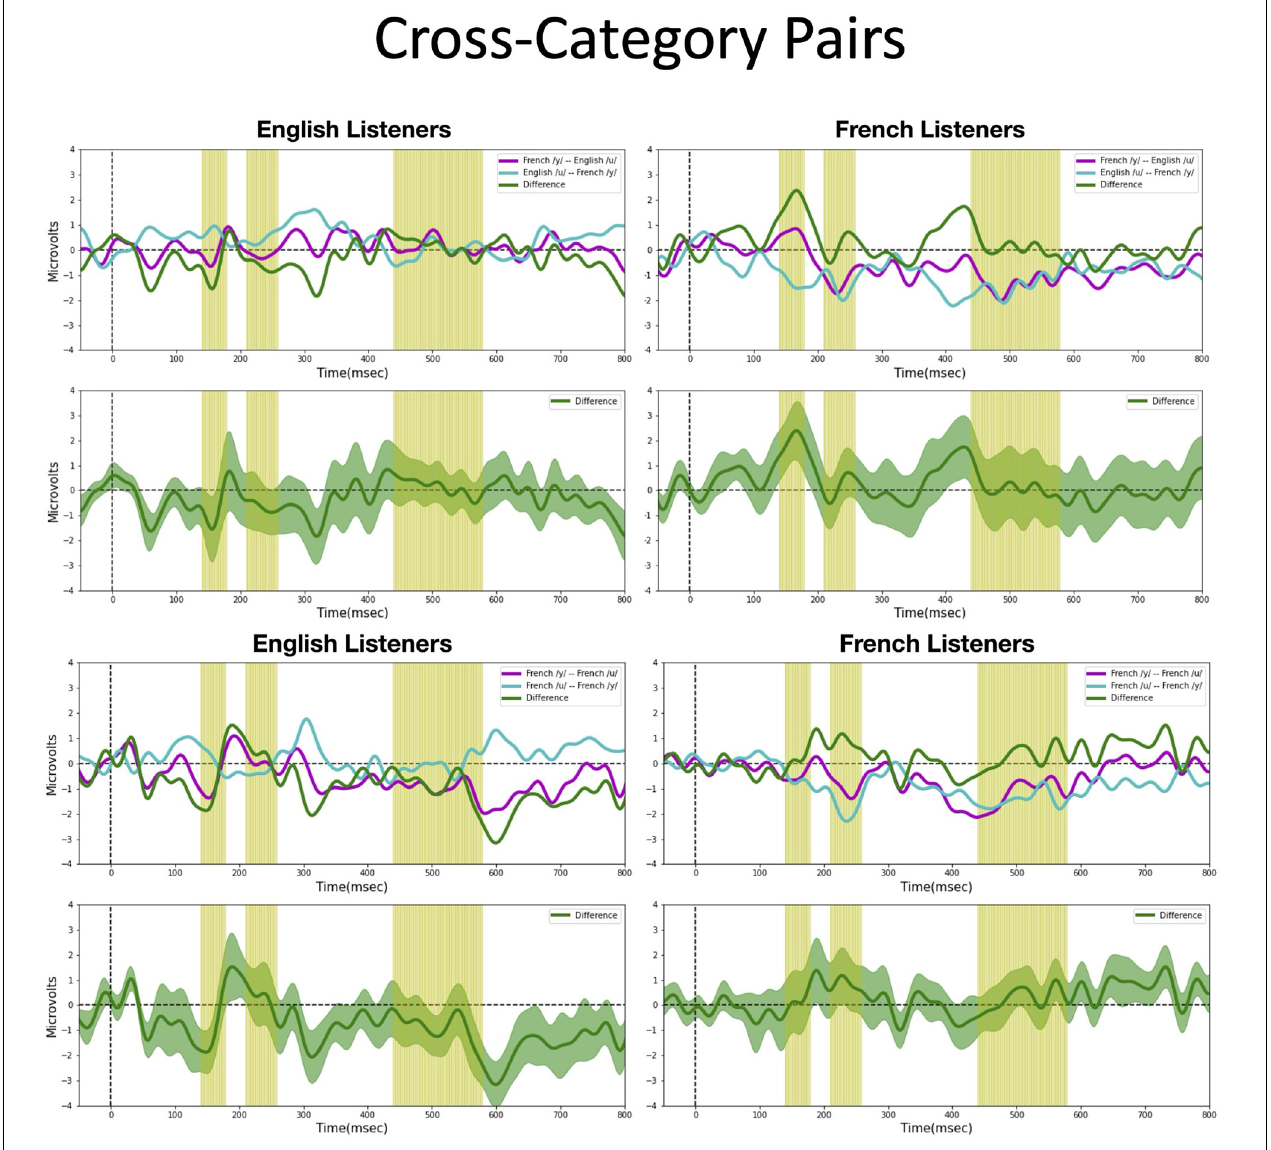
FIGURE 5 | Mismatch negativities (as described in Figure 3C ) for each stimulus type: Cross-category pairs, the mean MMNs for each stimulus presentation order (purple and turquoise lines) and difference waveform (green lines) (in the top half of each panel) and the difference waveform plotted with the standard error for the group (as the dark green shaded region) in the bottom half of each panel. The light green shading indicates the pre-selected time windows used in the hypothesis-based anayses. The MMNs are plotted for each language group wth English Listeners on the left and French Listeners on the right. The vowel pair for each MMN is indicated in the legend at right hand corner of each panel with the standard followed by the deviant (e.g., French /y/ – French /u/ denotes an MMN with French /u/ (V1) as the deviant in the context of French /y/ (V4) as